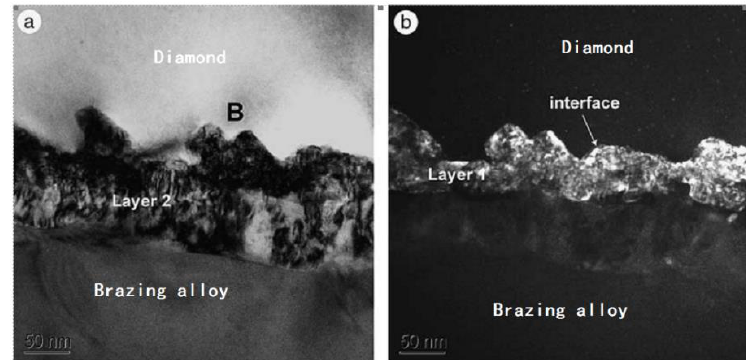
Figure 3. TEM (transmission electron microscope) photographs of two TiC layers after interface reaction: ( a ) bright field image; ( b ) dark field (DF) image g-vector = (111) TiC [15]. Reproduced with permission from Scripta Materialia, Elsevier, 2004.